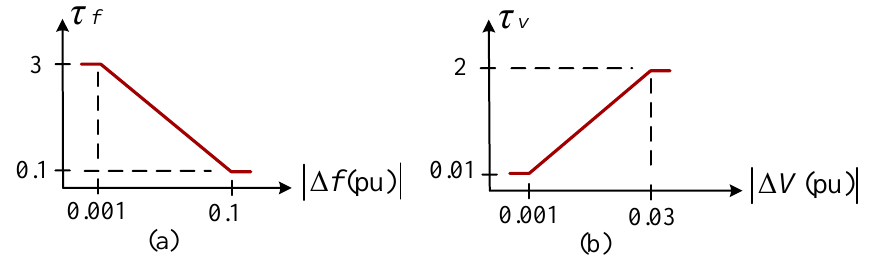
Figure 5. Variable time-constants for low-pass filters ( a ) for virtual governor and ( b ) for virtual